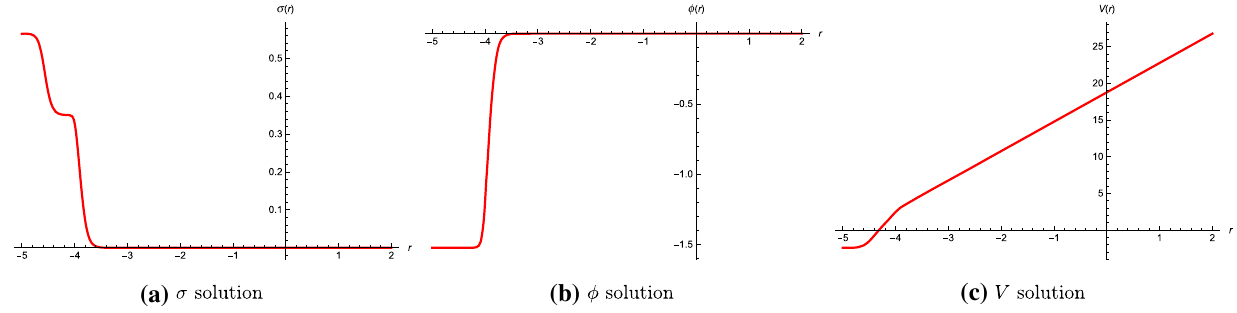
Fig. 19 An RG flow from SO ( 4 ) N = ( 1 , 0 ) SCFT to SO ( 3 ) N = ( 1 , 0 ) SCFT in six dimensions and to two-dimensional N = ( 1 , 0 ) SCFT with SO ( 3 ) diag symmetry dual to AdS 3 × CH 2